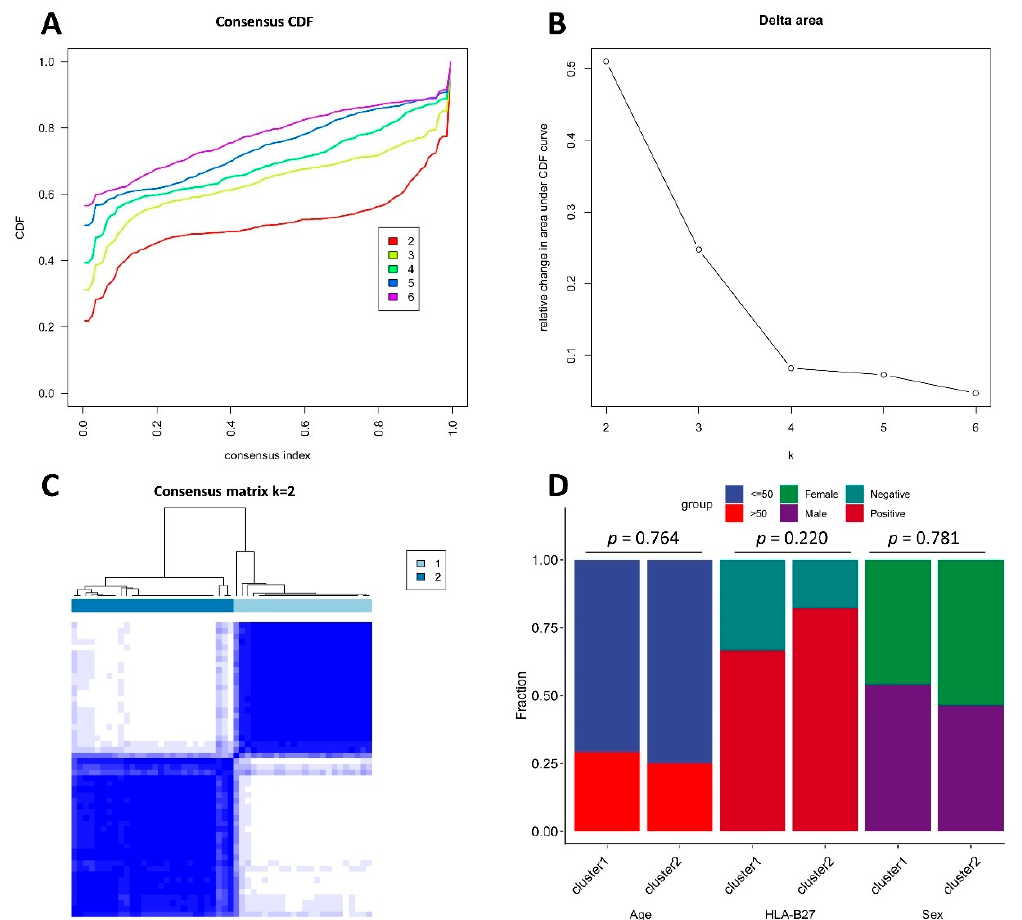
Figure 2. Visualization of consensus clustering. ( A , B ) Empirical consensus CDF plots and delta area score plots for k = 2 to 6, indicating that k = 2 or 3 is acceptable. ( C ) Consensus score matrix for the 52 AS samples obtained from GSE73754 when k = 2. Given our sample size and interpretability, the optimal k value was set as 2. ( D ) Percentage bar chart showing age, HLA-B27 status, and sex distribution in the two clusters. No statistical difference was identified. CDF, cumulative distribution function.